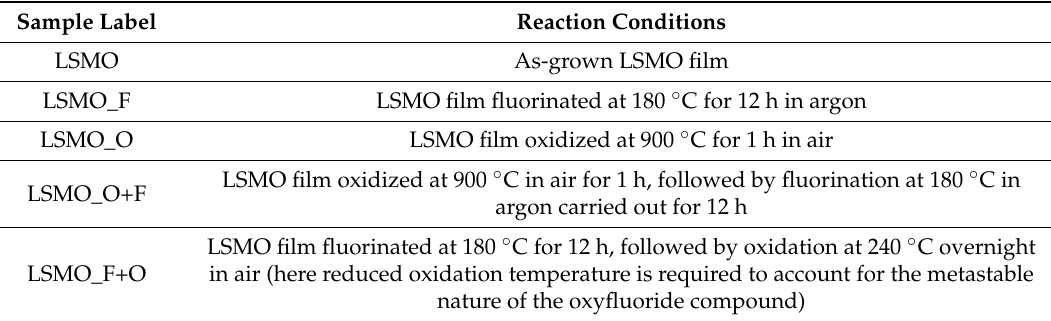
Table 1. Synthesis conditions for the different La 0.74 Sr 0.26 MnO 3 − δ (LSMO)-based films reported in this